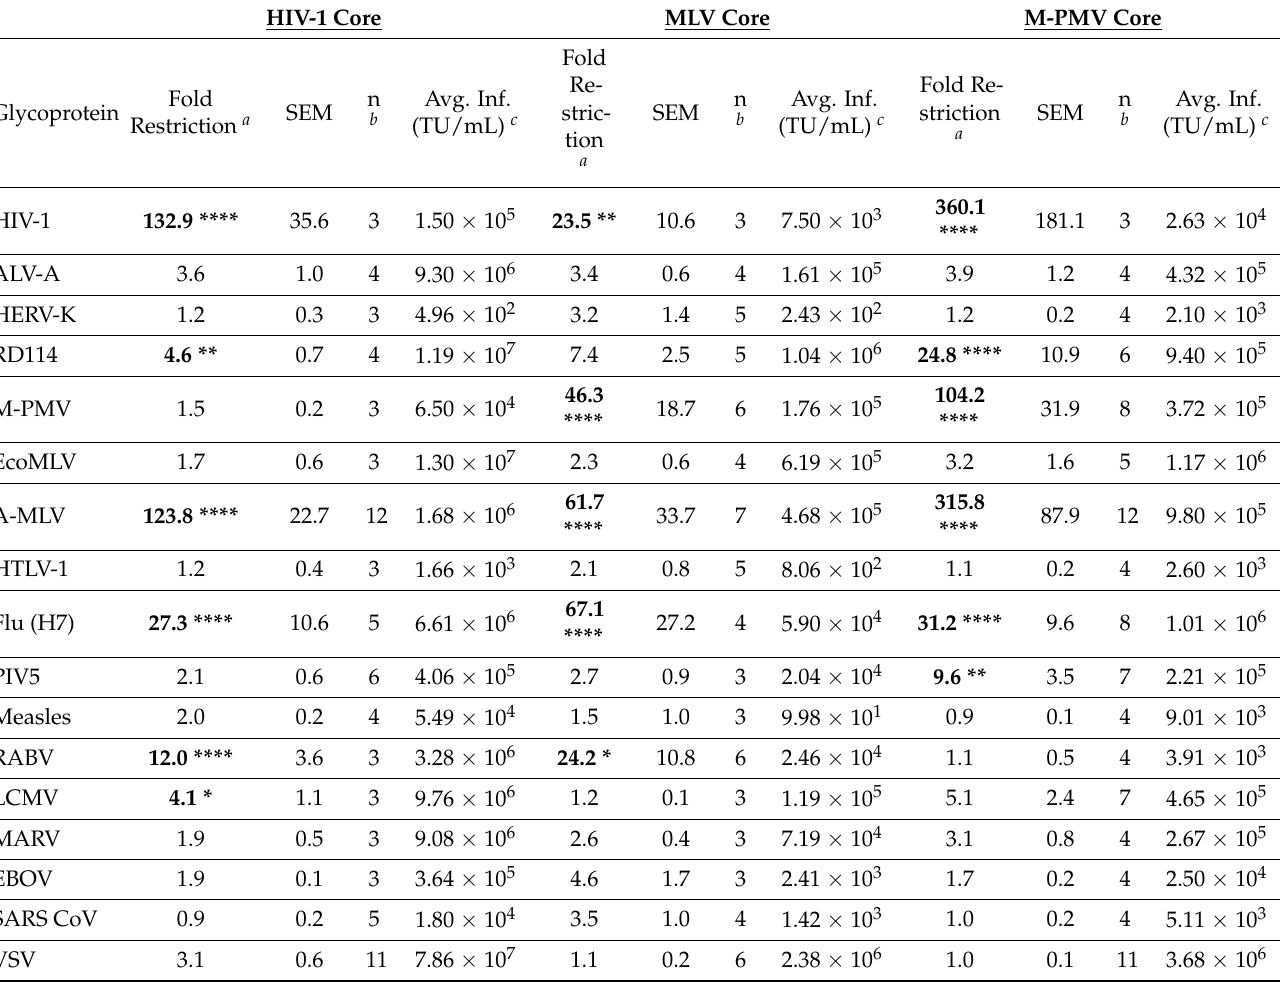
Table 1. Magnitude of SERINC5-mediated restriction and absolute infectivity for pseudotypes with the indicated viral glycoproteins on the indicated virion cores.